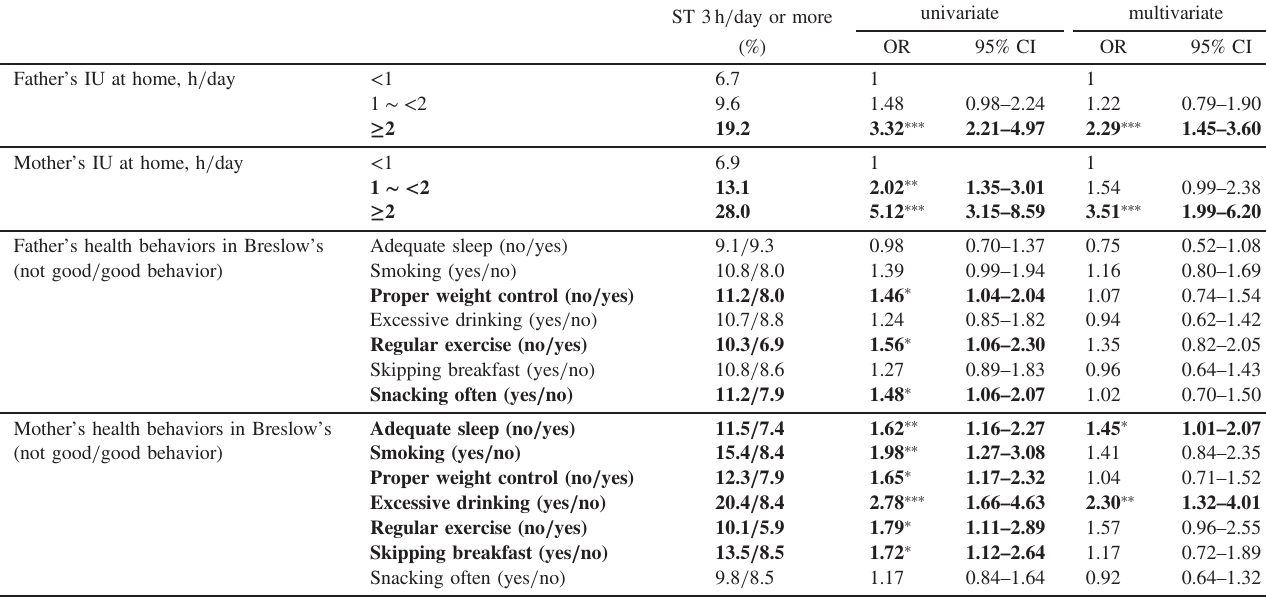
Table 3. Associations of parental IU and lifestyles with children ’ s prolonged ST ( n = 1,659)